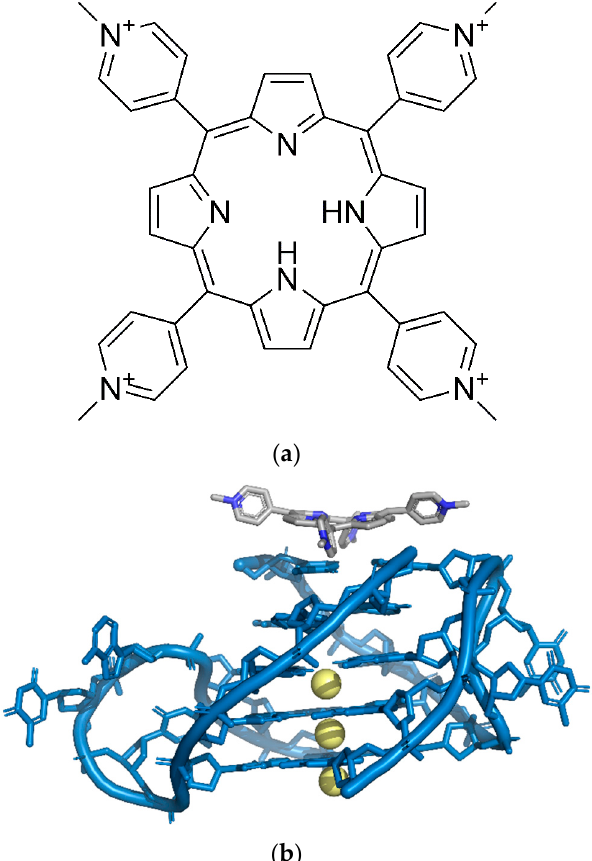
Figure 7. ( a ) Chemical structure of TMPyP4 ( b ) A parallel stranded human telomeric quadruplex in complex with the porphyrin TMPyP4 (PDB: